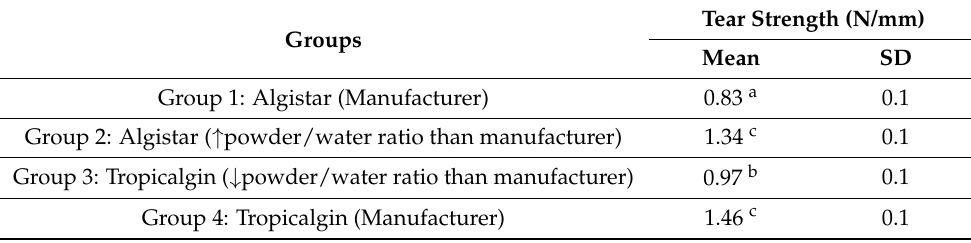
Table 4. Tear strength values of the different groups (N/mm).